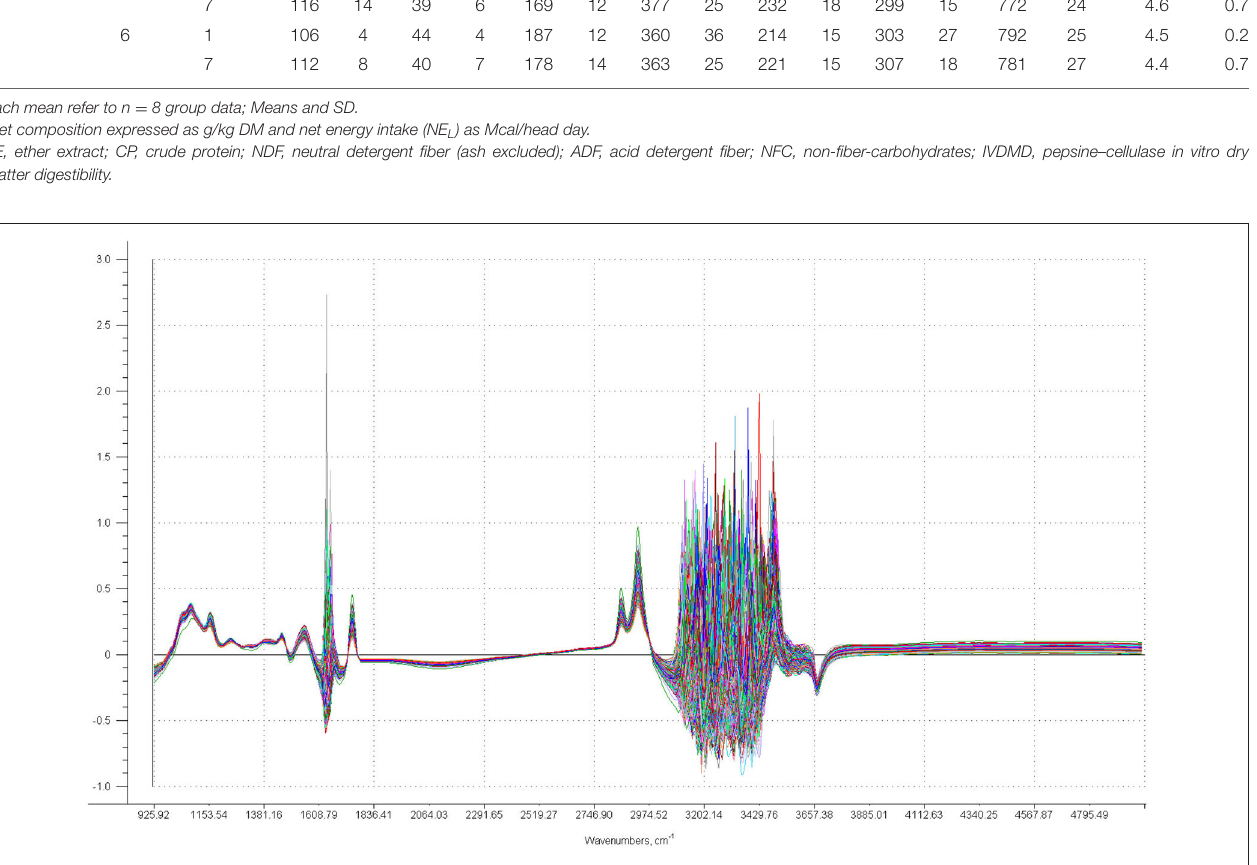
FIGURE 1 | Plot of the overlapped 1,230 milk sample